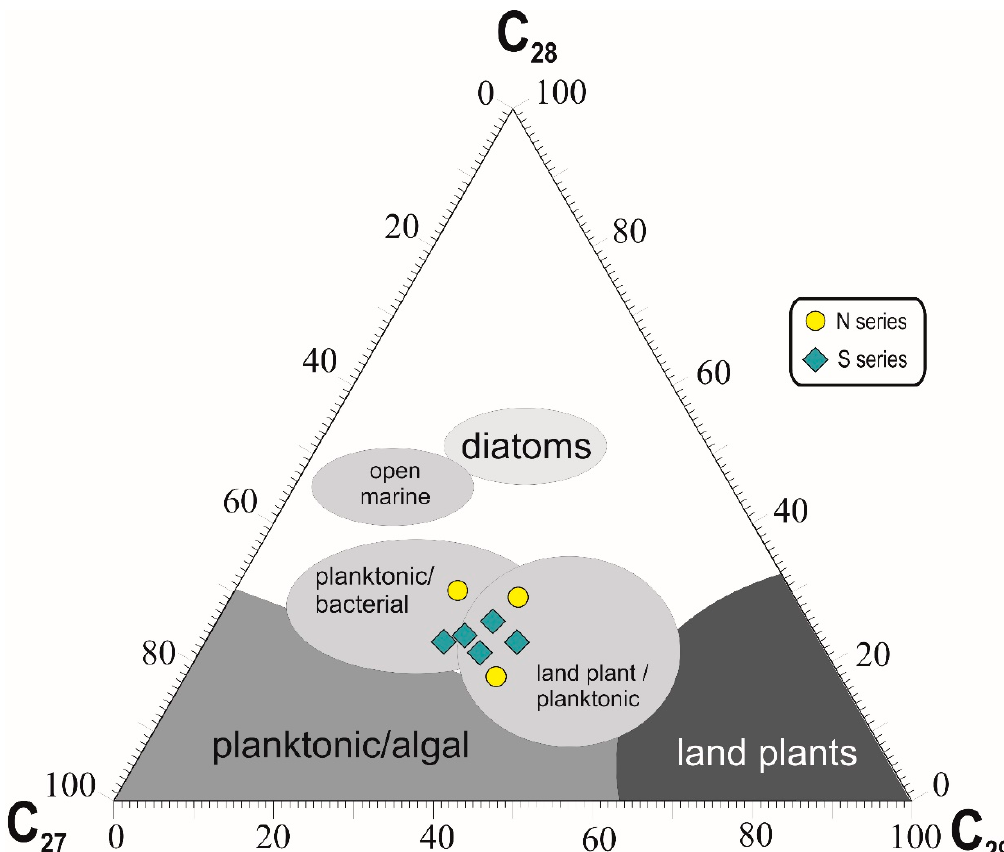
Figure 13. Ternary diagram of relative percentage of cholestanes (C 27 ), ergostanes (C 28 ) and stigmastanes (C 29 ). Values of sterane maturity ratios, i.e., the ratio of 5 α ,14 β ,17 β (H)-stigmastanes to the sum of all stigmastane diastereomers (C 29 ααα /( ααα + αββ )) and the ratio of C 29 - 5 α ,14 α ,17 α (H)-stigmastane 20S to the sum of its diastereomers 20S and 20R [62] (Table 4)